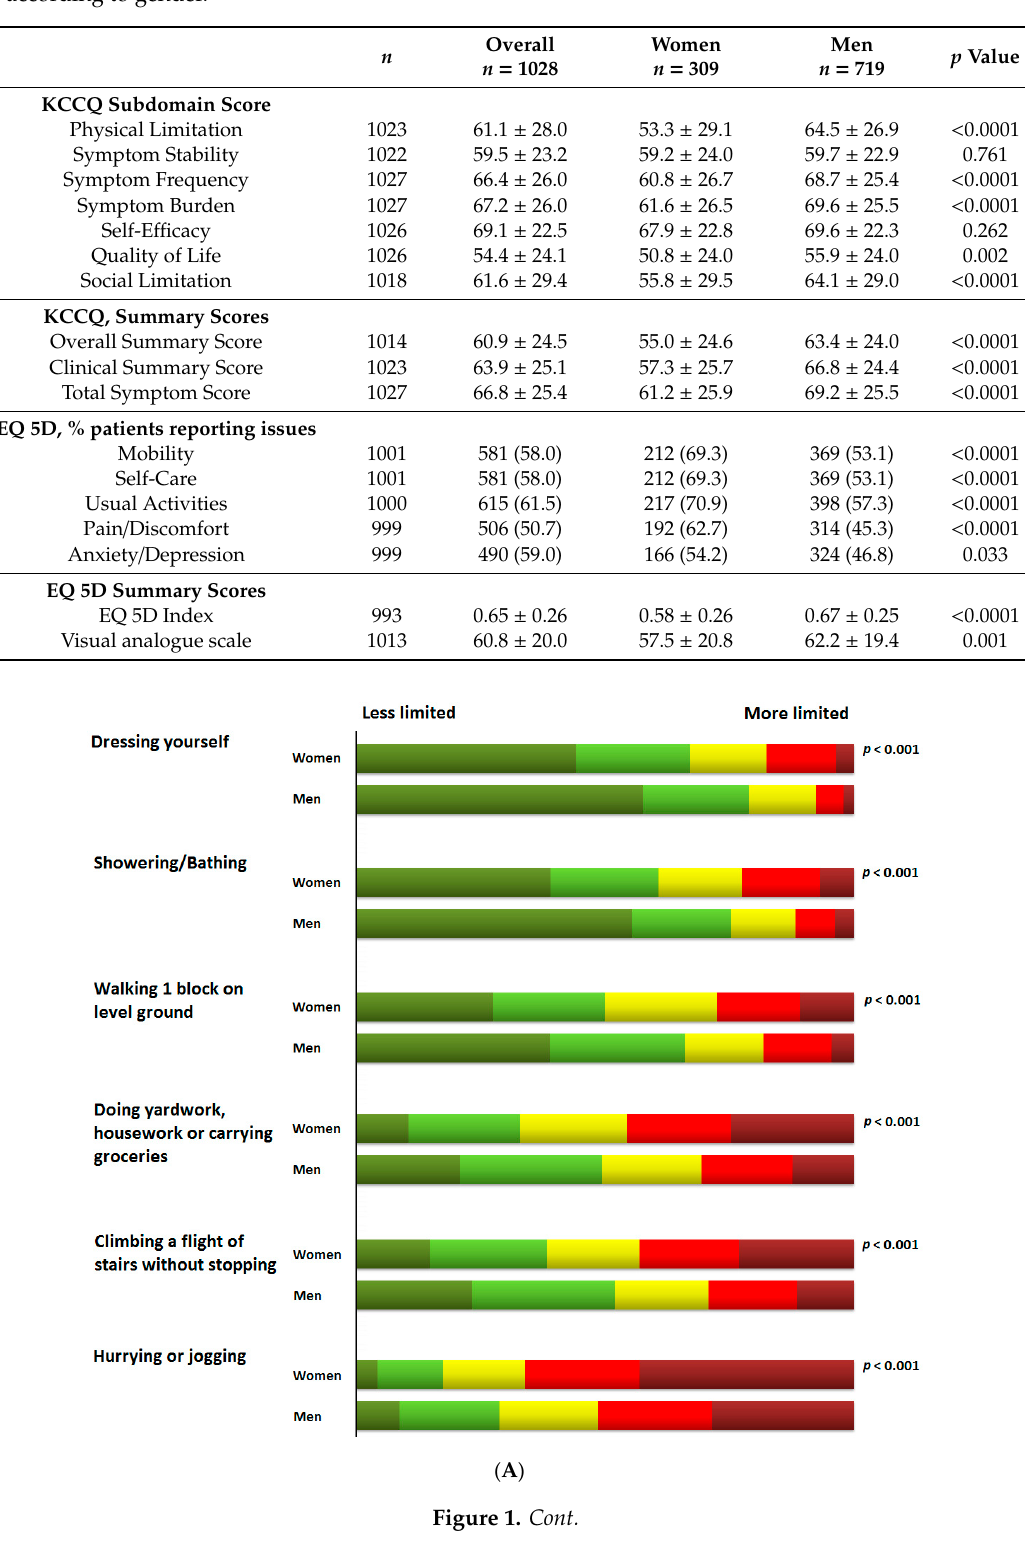
Table 2. Distribution of summary scores, dimensions, and domains of the Kansas City Cardiomyopathy Questionnaire (KCCQ) and EQ-5D quality of life questionnaires in the overall population studied and according to